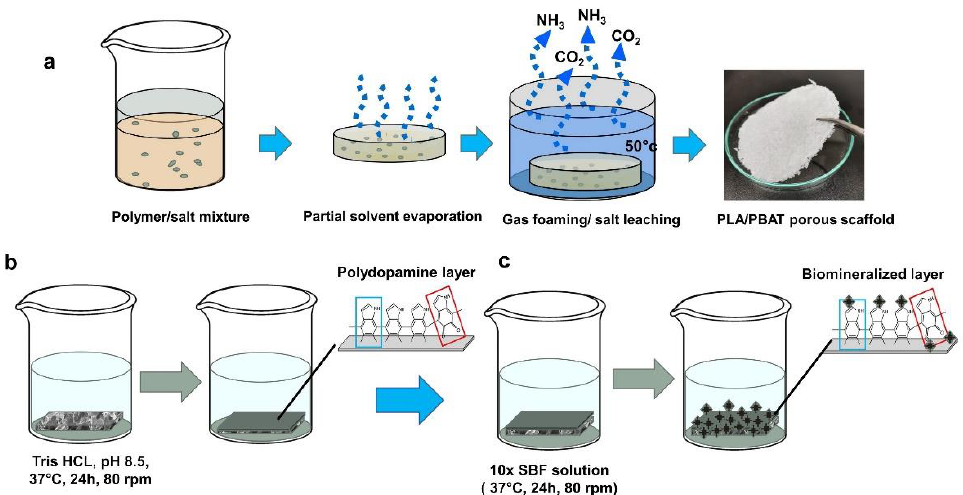
Figure 3. A schematic illustration of the preparation process of the porous PLA/PBAT scaffold with PDA-assisted biomineralization. ( a ) The fabrication of porous PLA/PBAT specimen via gas foam- ing/particulate leaching technique. ( b ) The formation of bioactive PDA layer on the surface of po- rous PLA/PBAT scaffold by soaking in dopamine solution. ( c ) The preparation of the biomimetic mineralized layer on PDA-coated film by soaking in 10× SBF-like solution.